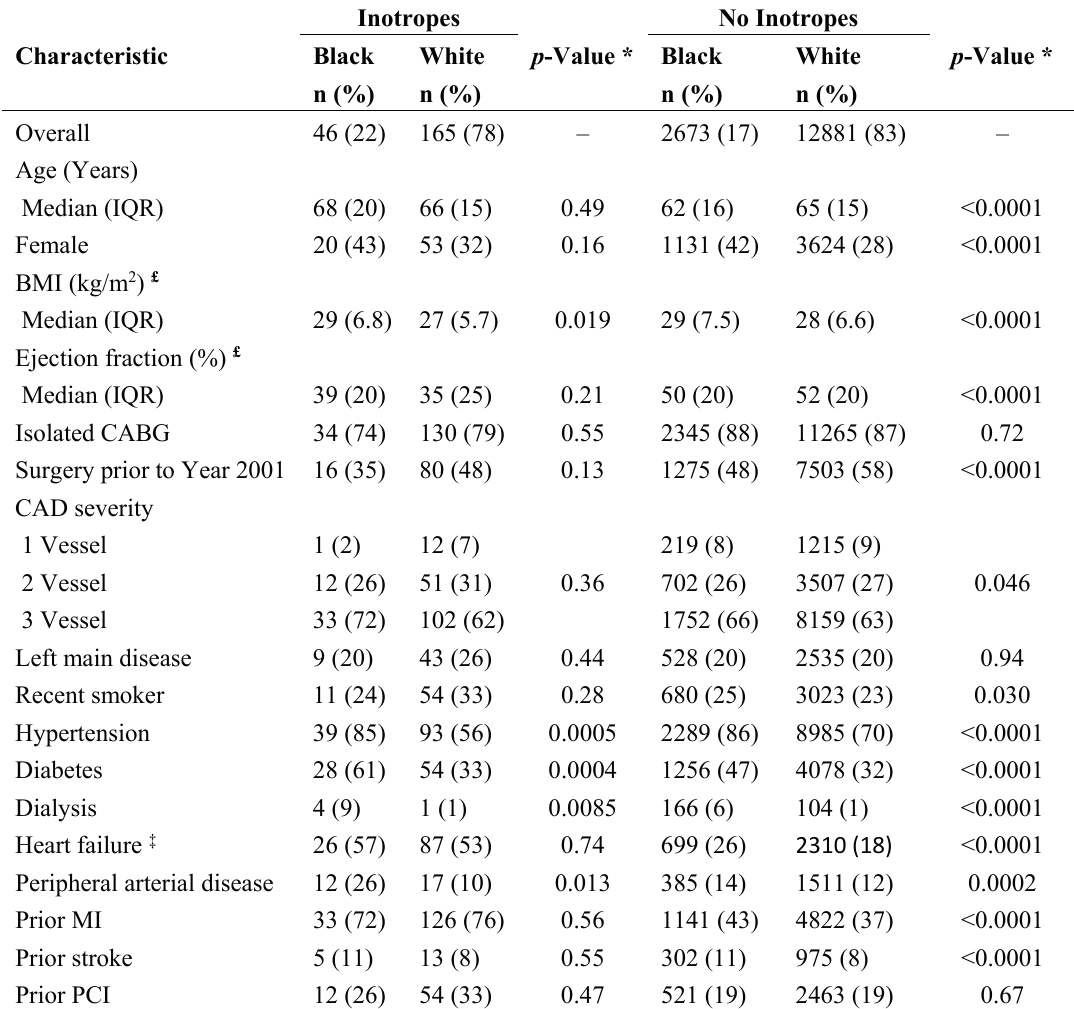
Table 1. Patient characteristics (N =